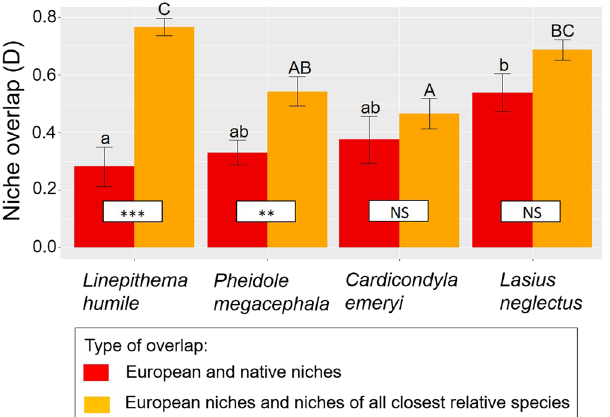
Figure 3. Niche overlap (D) values between European and native niches (red bars) and between European niches and niches of all closest relative species (orange bars) for each introduced ant species. The results of the two-way ANOVA test are included in the figure. Thus, the significance of differences ( NS , no significant; **, p < 0.001; ***, P < 0.0001) between type of overlap (between European and native niches and between European niches and niches of all closest relative species) for each species is shown at the basis of the bars. The differences among species within each type of overlap were tested with post-hoc Tukey tests comparing least square means and shown in the upper part of the bars: lower case and capital letters depict significant differences among species in overlap (D) values between European and native niches (red bars) and between European niches and niches of all closest relative species (orange bars),